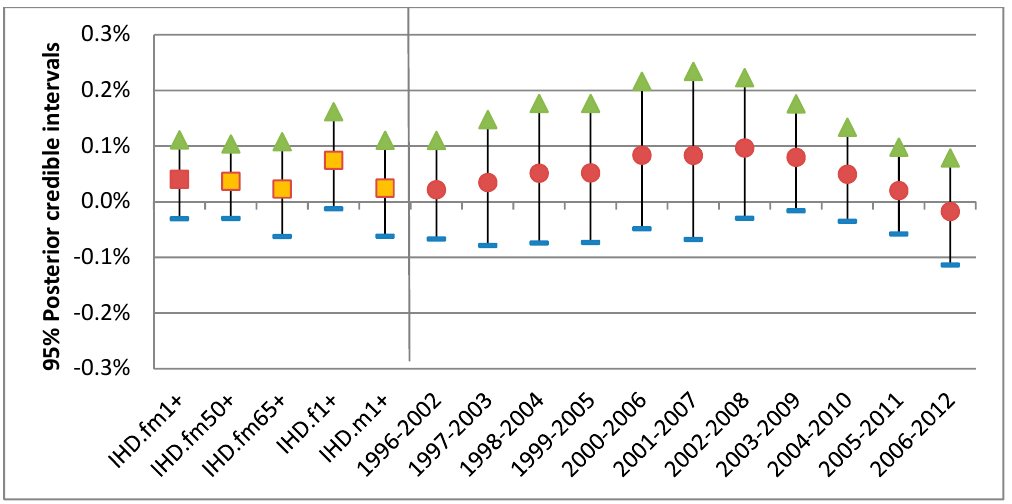
Figure 5. 95% posterior intervals for the associations per 10 ppb of 1-day lagged ozone with IHD hospitalizations for warm season: ( a ) 17 years combined risks for 5 groups (squares); ( b ) 11 annual risks of base group (circles in red).